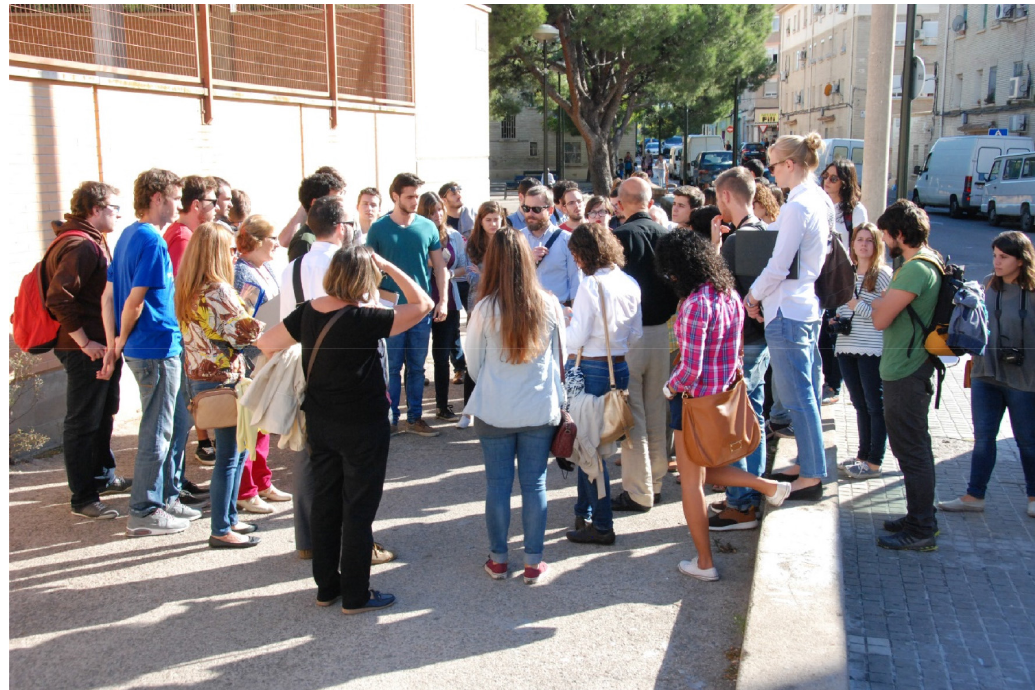
Figure 3. Analysis work session in the neighbourhood. Oliver